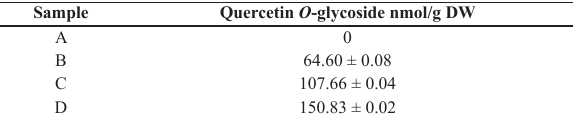
Table 1. Concentration of quercetin O -glycoside (nmol/g DW) in suspension cultures of A. vesicarius ssp. carniolicus; A – plant cells grown on G48 medium, non-treated with quercetin (control); B – plant cells grown on G48 medium, supplemented with 1 mg/mL quercetin; C – G48 medium, supplemented with 2 mg/mL quer- cetin; D – G48 medium, supplemented with 3 mg/mL quercetin.